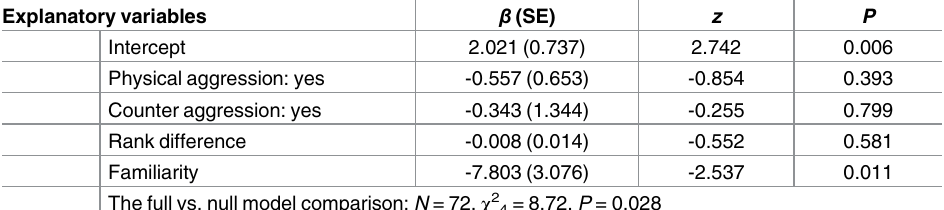
Table 3. GLMM logistic regression results for the factors affecting vocal use of victims in post-con- flict interactions with the former opponent. Explanatory